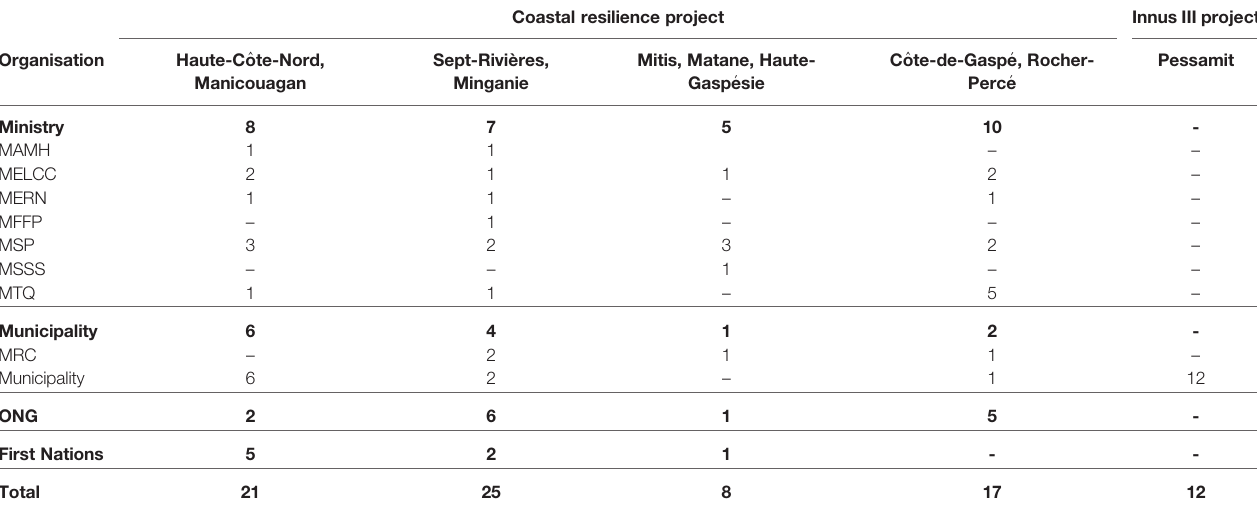
Bold values indicate the sommation of the organisation